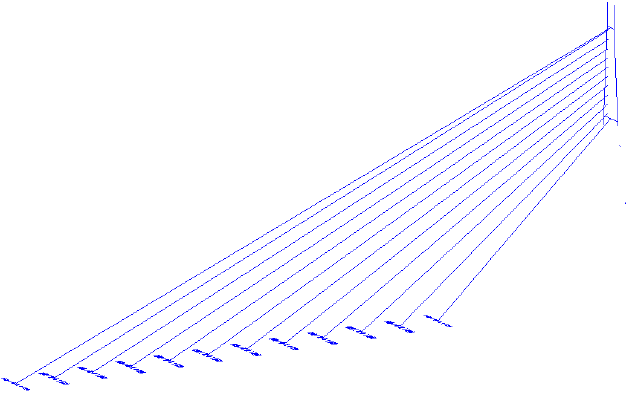
Figure 4. Ansys bridge model.